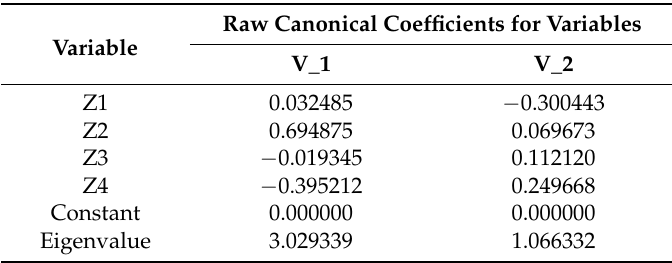
Table 7. Raw canonical function coefficients.